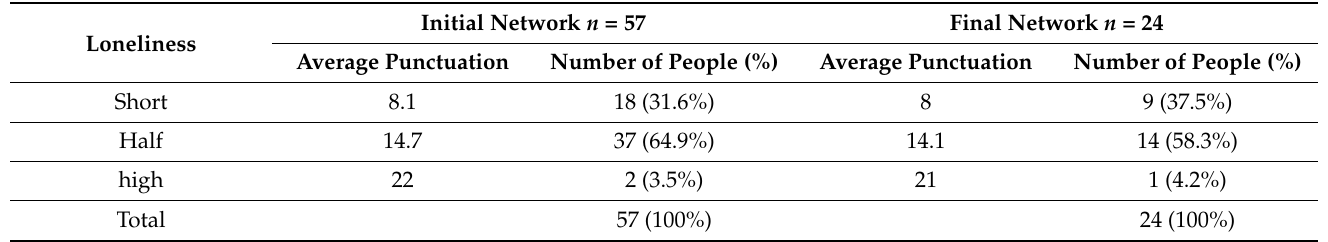
Table 5. Assessment of loneliness in the initial and final network.